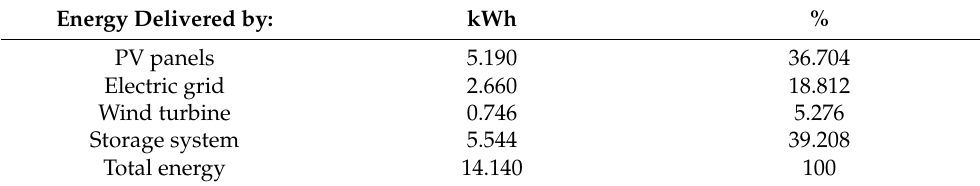
Figure 13. Distribution of electricity produced by each source. Third scenario data.